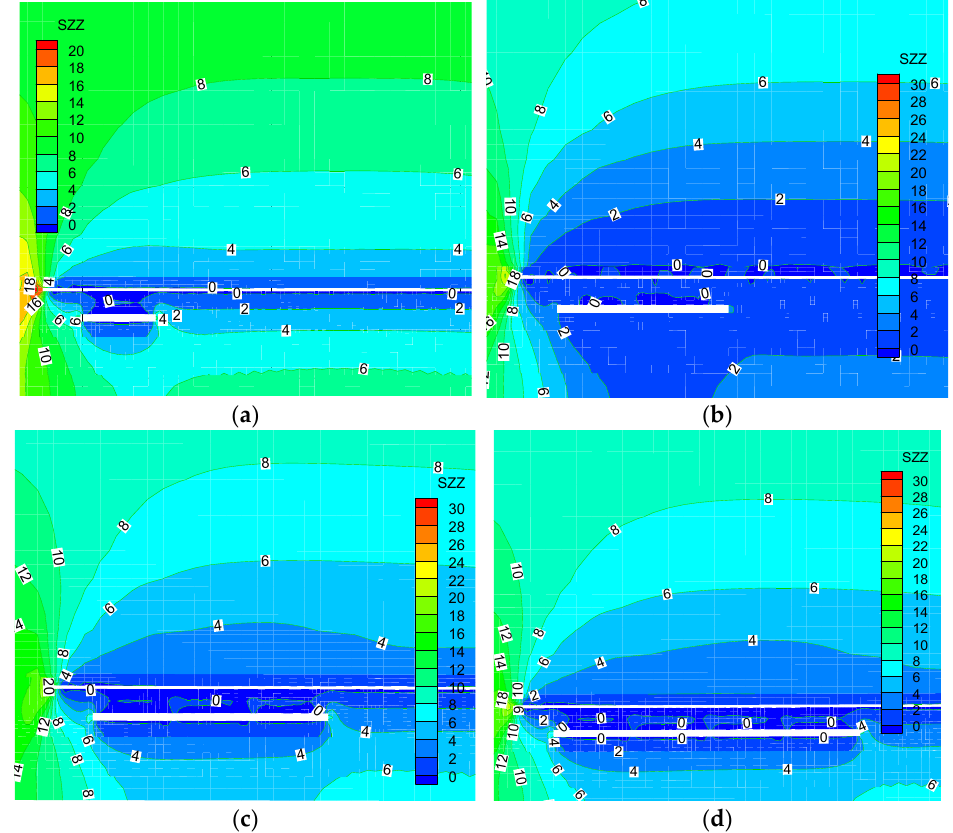
Figure 11. Vertical stress distribution of surrounding rock in lower coal seam #9. ( a ) Advancing 20 m. m. ( b ) Advancing 40 m. ( c ) Advancing 60 m. ( d ) Advancing 80 m. ( b ) Advancing 40 m. ( c ) Advancing 60 m. ( d ) Advancing 80 m.